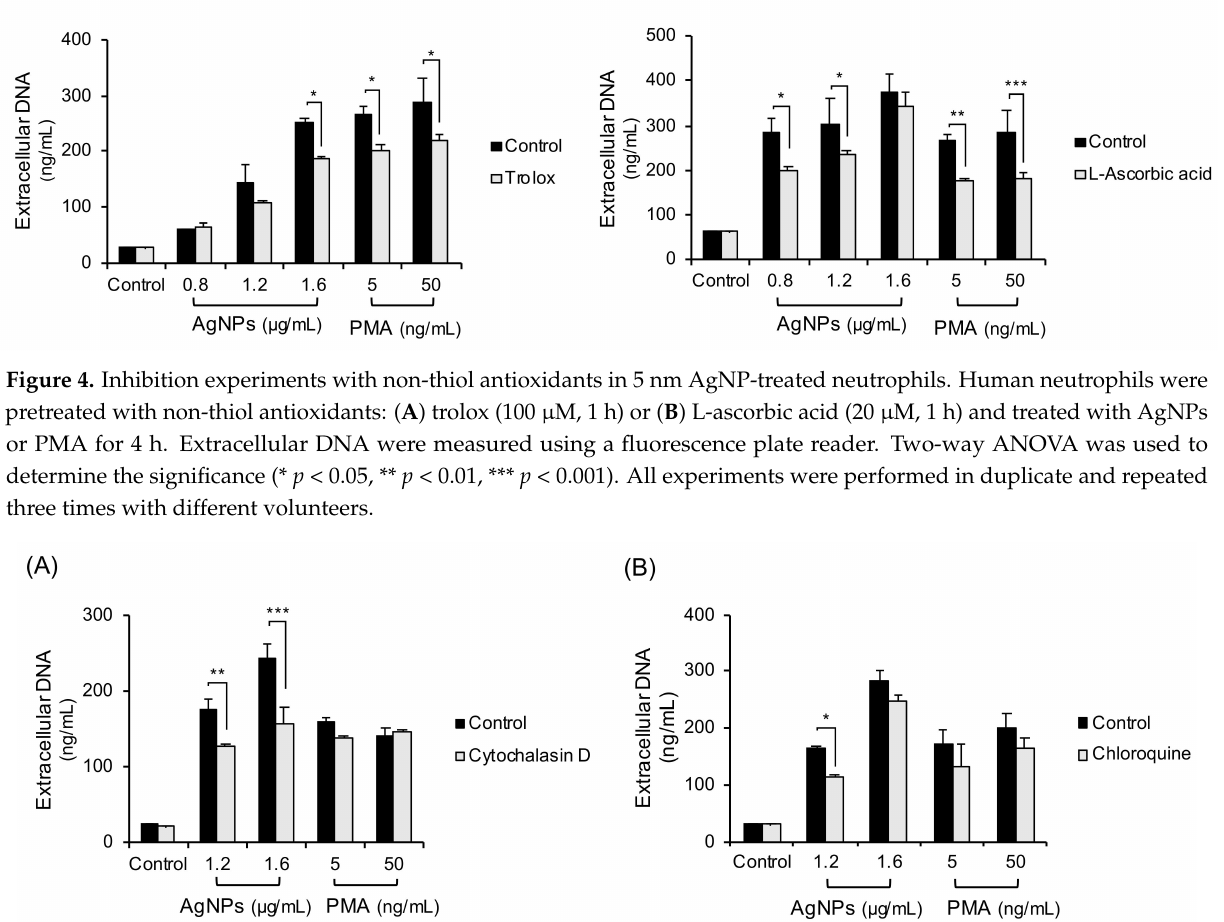
Figure 5. Inhibition of phagocytosis-lysosome process in 5 nm AgNP-treated neutrophils. Human neutrophils were pretreated with inhibitors that included ( A ) cytochalasin D (20 µ M, 20 min) (phagocytosis inhibitor) or ( B ) chloroquine (3 µ M, 1 h) (lysosome inhibitor) and followed by 4 h exposure to AgNPs or PMA. Extracellular DNA were measured by a fluorescence plate reader. Two-way ANOVA was used to determine the significance (* p < 0.05, ** p < 0.01, *** p < 0.001). All experiments were performed in duplicate and repeated three times with different